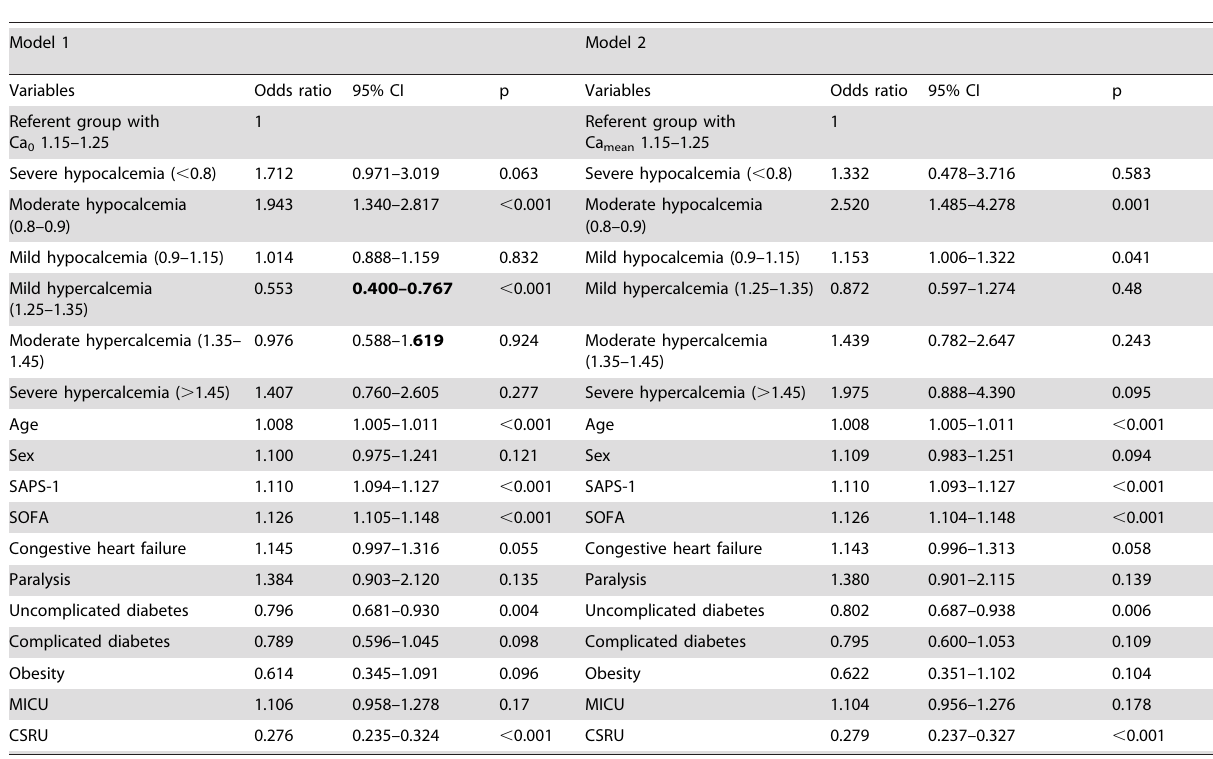
Table 4. Multivariable logistic regression categorizing calcium values into design